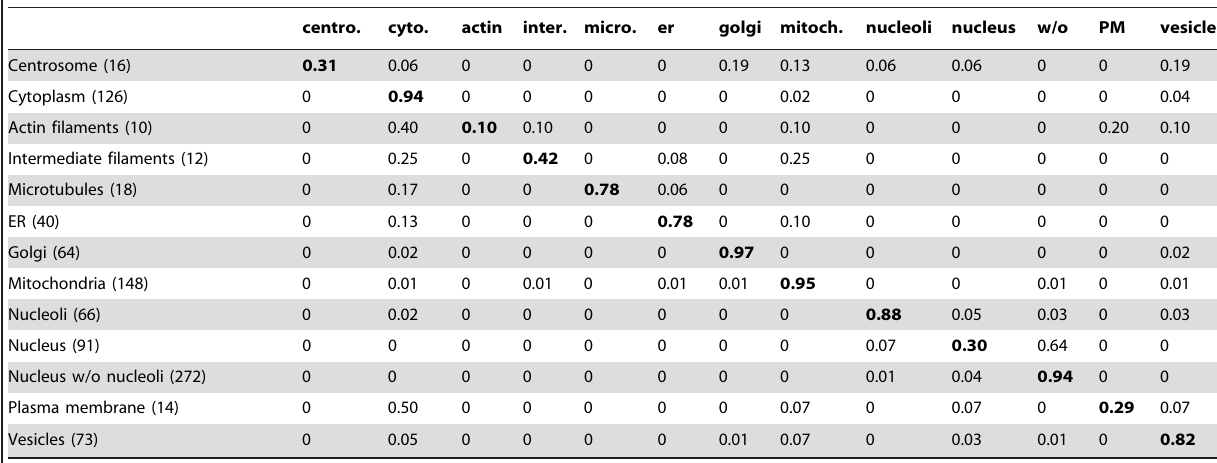
Table 5. Classification results after second round of reannotation.